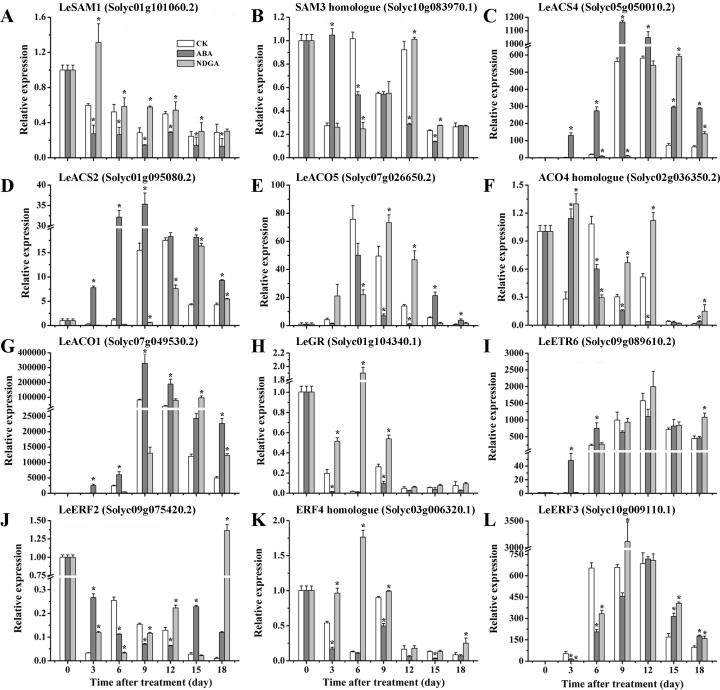
The expression of DEGs related to ethylene biosynthesis and signaling in CK, ABA and NDGA-treated fruits at different ripening stages.RT-PCR analysis of SAM1 (A), SAM3 (B), ACS1 (C), ACS2 (D), ACO1 (E), ACO4;1 (F), ACO4;2 (G), RTE1 (H), ETR2 (I), EBP (J), ERF4;1 (K) and ERF4;2 (L) were conducted in CK vs ABA and CK vs NDGA treatment. Other details are the same as in Fig 5.